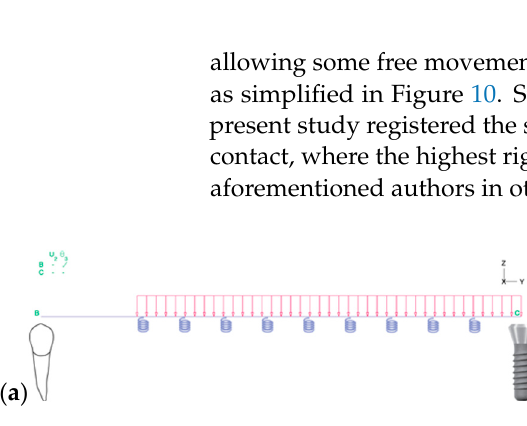
Figure 10. Representation of the IARPD MOLARS model as a simple supported beam with a non-rigid support in the abutment tooth and a rigid support in the implant. ( a ) Springs represent the vertical resistance promoted by the soft tissues and the occlusal load is distributed exclusively over the replacement teeth. ( b ) Schematic representation of the pattern of vertical displacement occurring in each of the extension bases of an implant-assisted Kennedy Class I RPD with distal support as a simple supported beam Euler–Bernoulli